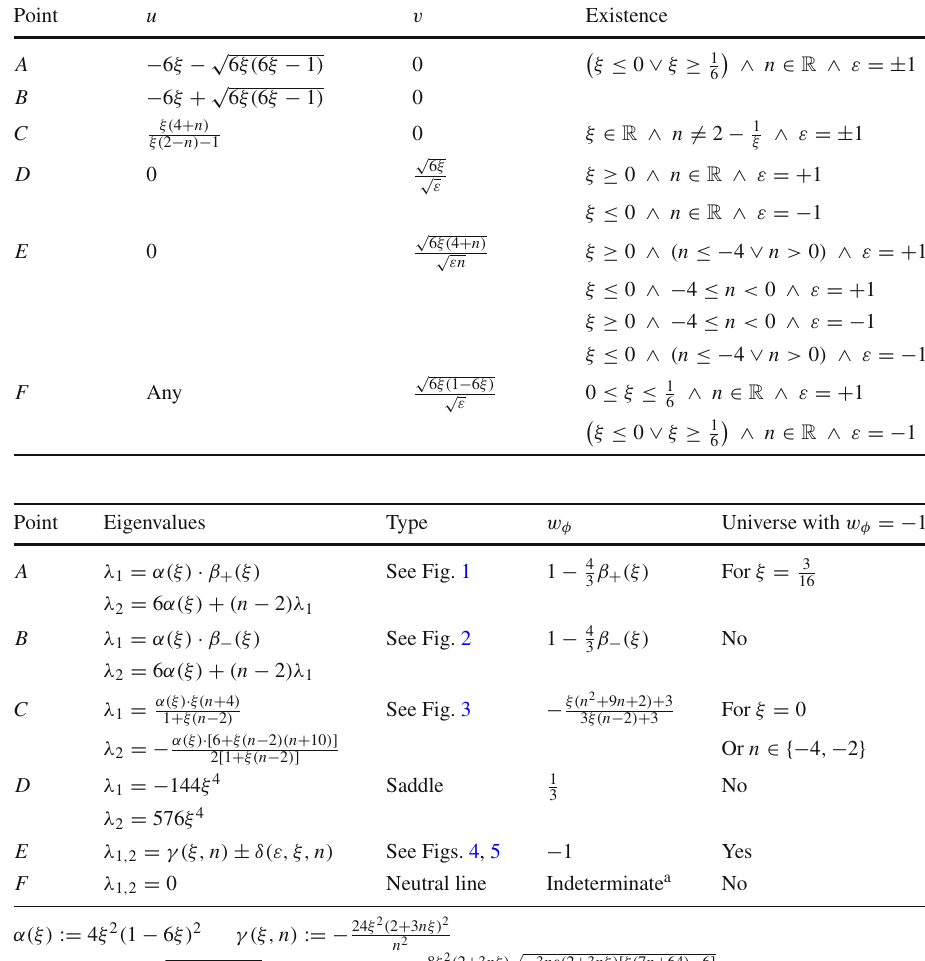
Table 1 Finite equilibria of the system (25) with existence conditions